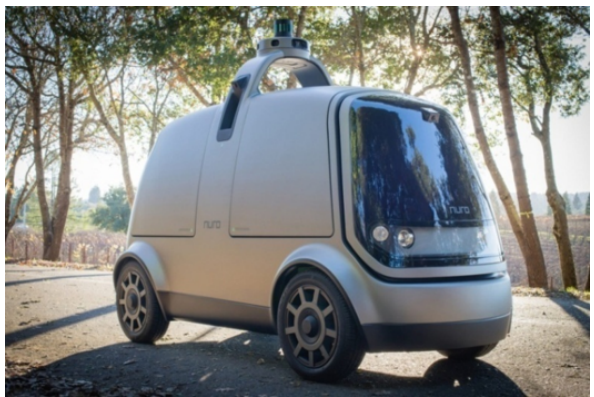
Figure 2: Nuro autonomous vehicle